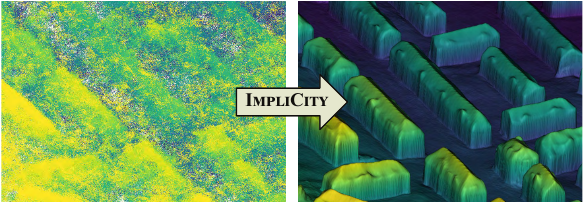
Figure 1. I MPLI C ITY is a deep, implicit representation of surface geometry. It is derived from a photogrammetric 3D point cloud and associated images. Note the geometric details on the roofs despite the substantial noise level of the input point